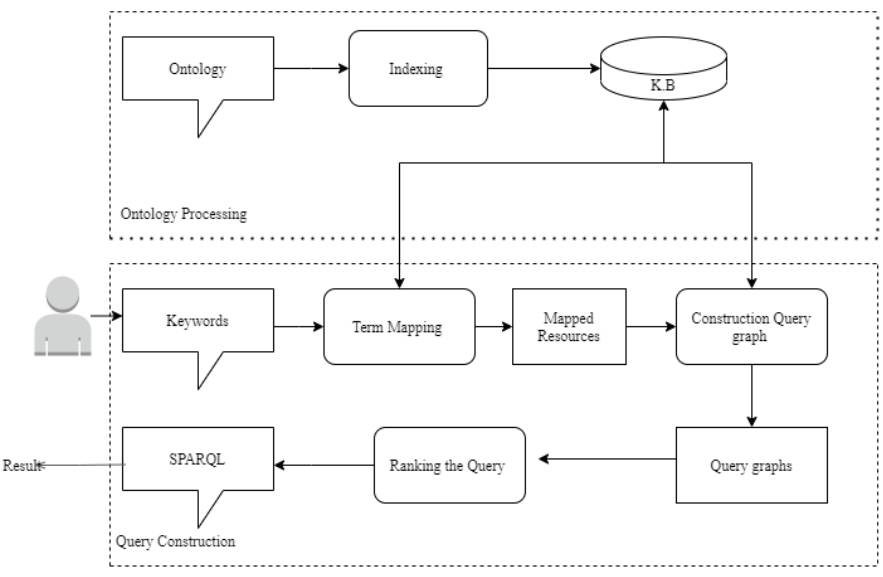
Figure 10. Spark